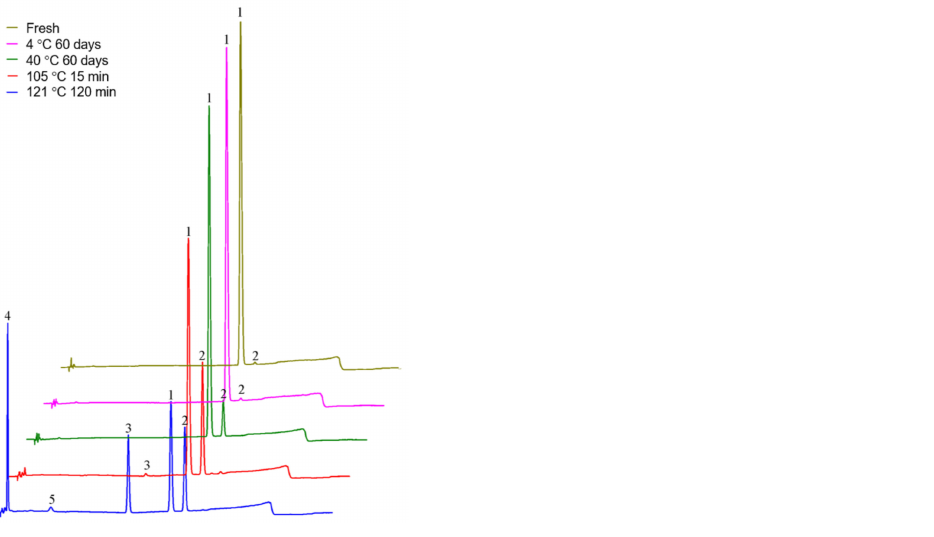
Figure 5. Formation of impurities in the cis -lobeline reference solution after it was treated by different temperature. 1 = cis -lobeline, 2 = trans -lobeline, 3 = Intermediate, 4 and 5 = unknown impurities. Table 6. Relationship between temperature and degree of isomerization ( n = 3).